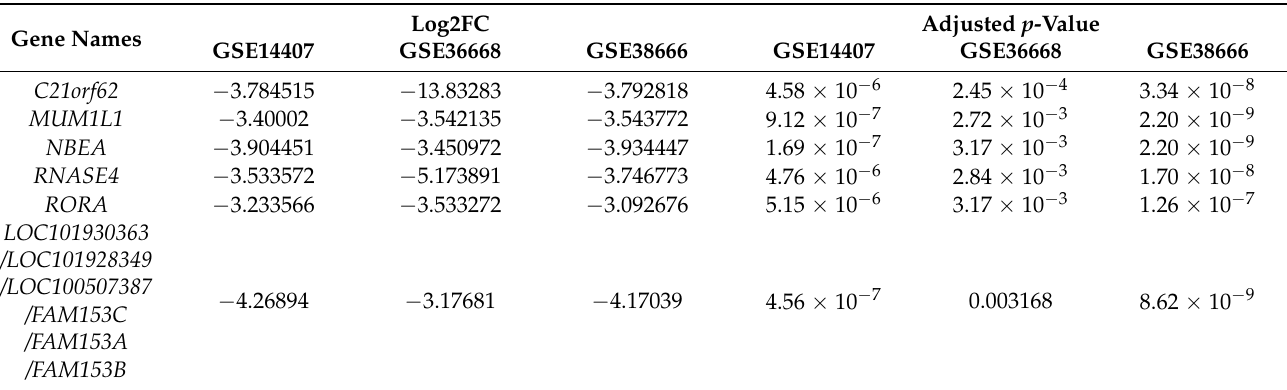
Table 3. Down-regulated DEGs in serous ovarian cancer of the GEO datasets.